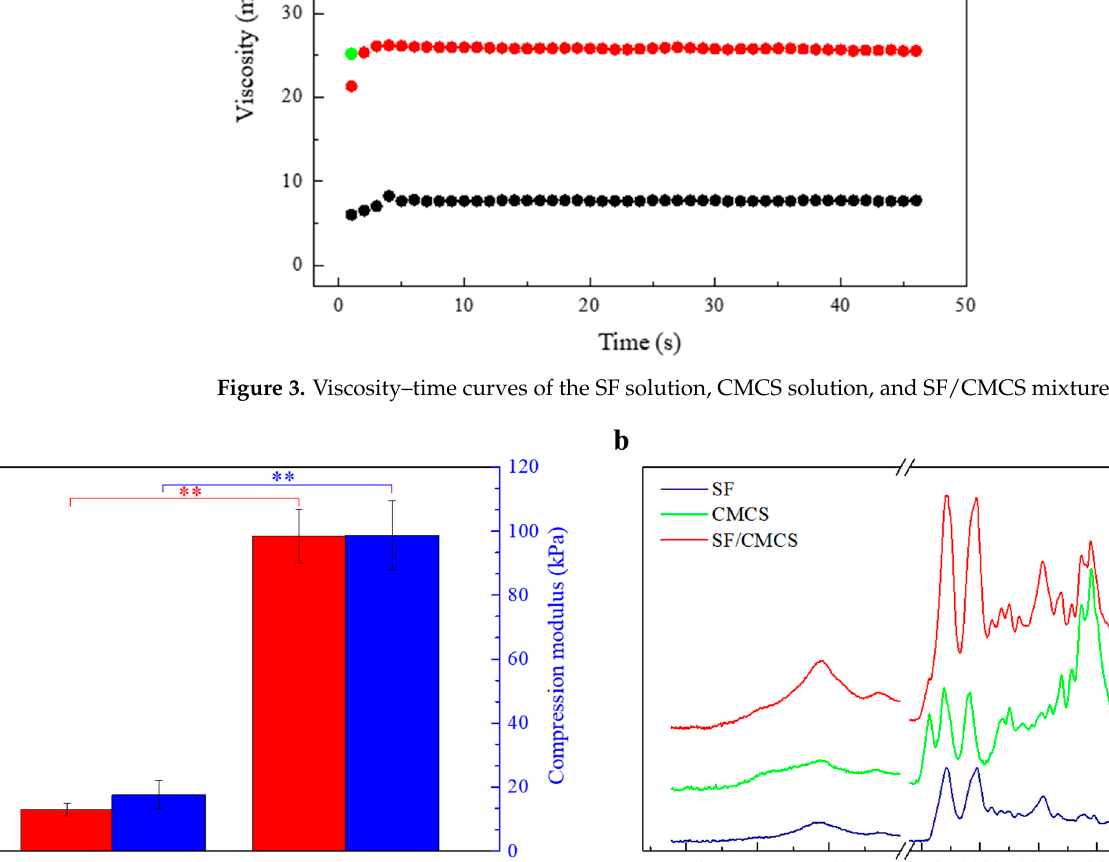
Figure 3. Viscosity–time curves of the SF solution, CMCS solution, and SF/CMCS mixture.